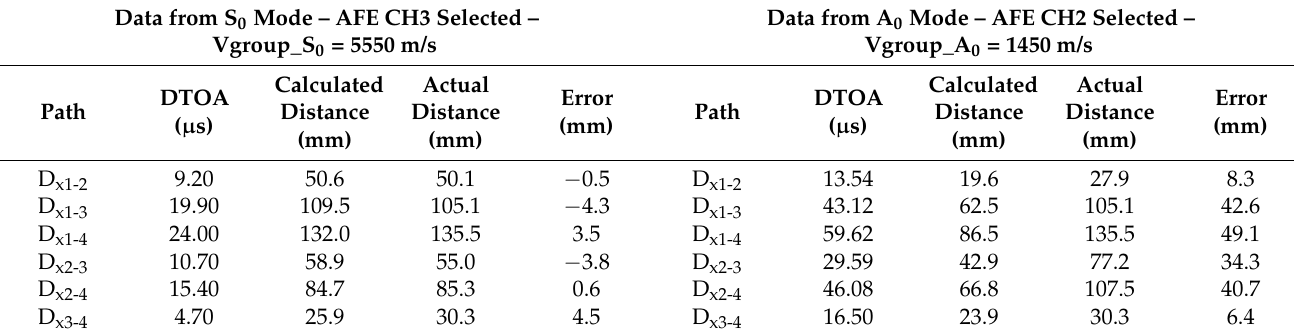
Table 6. DToAs and distance estimation with A 0 and S 0 mode